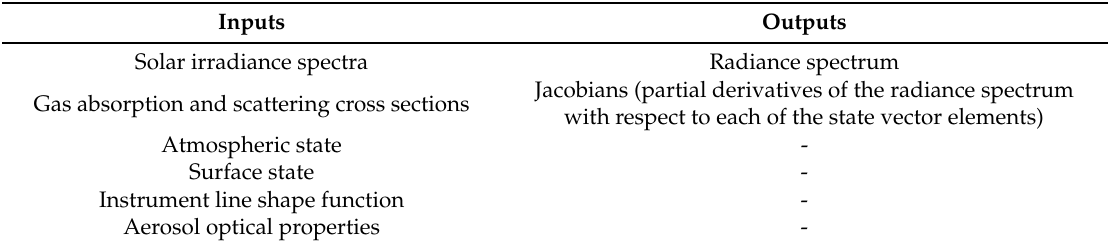
Table 4. SCIATRAN model inputs and